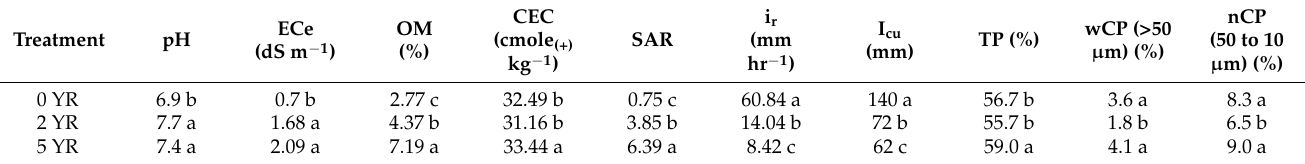
Table 2. Mean values of soil chemical properties, infiltration rate, and accumulated infiltration for the three treatments.